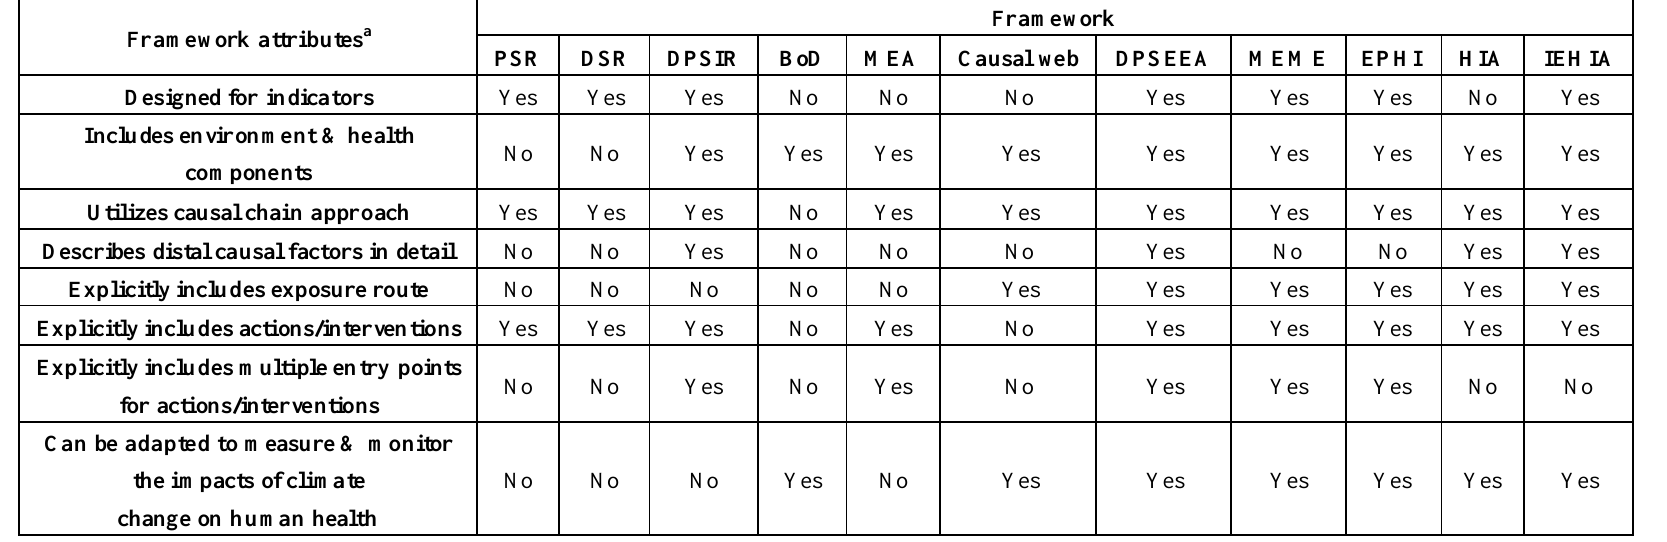
Table 1. Attributes of the